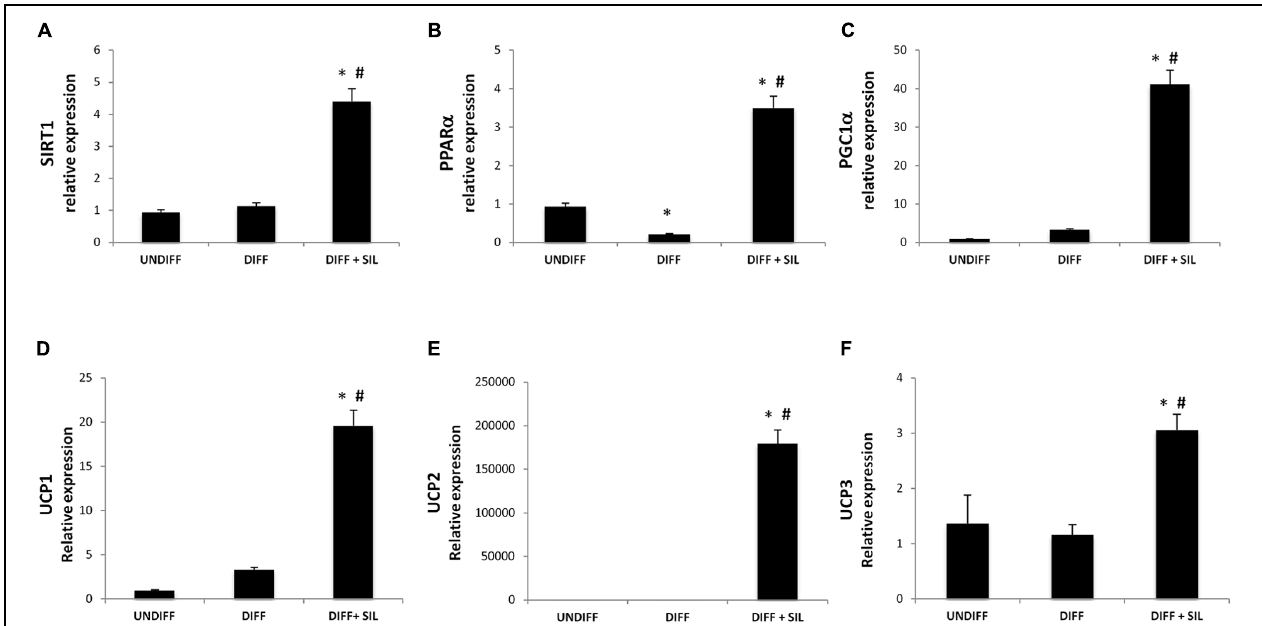
FIGURE 3 | Analysis of gene expression by Real time PCR of SIRT1 (A), PPAR α (B), PGC1 α (C), UCP1 (D), UCP2 (E), and UCP3 (F). All values are expressed as mean ± SEM of four experiments ( n = 4) in duplicate. ∗ P < 0.05 vs. undifferentiated; # P < 0.05 vs. differentiated.